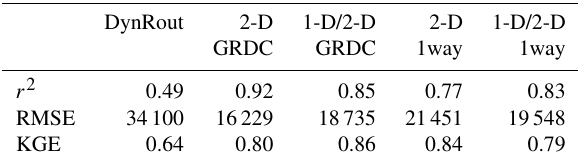
Table 1. Performance of model runs in objective functions for both actual and scaled model input. The term “1way” indicates one-way coupled